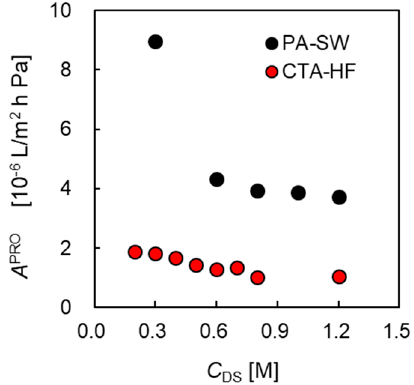
Figure 10. Apparent water permeability coefficient, A PRO , as a function of DS concentration, C DS . FS: treated tap water. Q DS : 10.0 L/min. Q FS : 5.0 L/min.